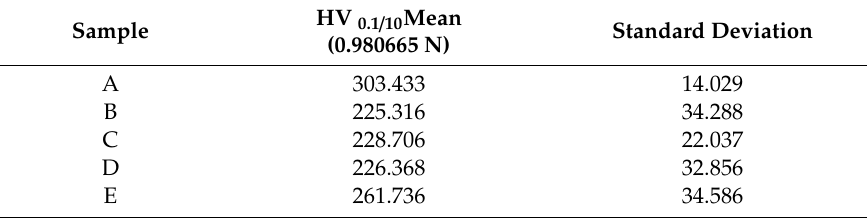
Table 3. Average HV 0.1 / 10 hardness for the five